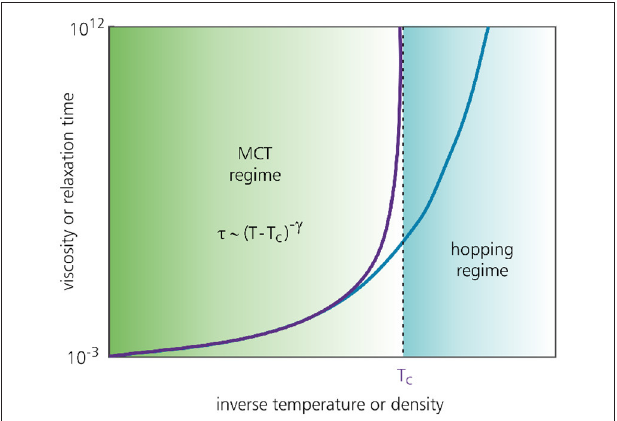
FIGURE 8 | Typical MCT prediction (purple curve) and simulation result (blue curve) for the dynamical slowdown of a glass-forming material as a function of the control parameter. MCT generally predicts that the viscosity or relaxation time grows as a power law and diverges at the glass transition temperature T c or critical packing fraction φ c . In reality, a material tends to remain in the supercooled-liquid phase at temperatures well below T c (or packing fractions above φ c ), which is attributed to so-called activated or hopping dynamics missing in standard MCT. The figure is based on Charbonneau et al.